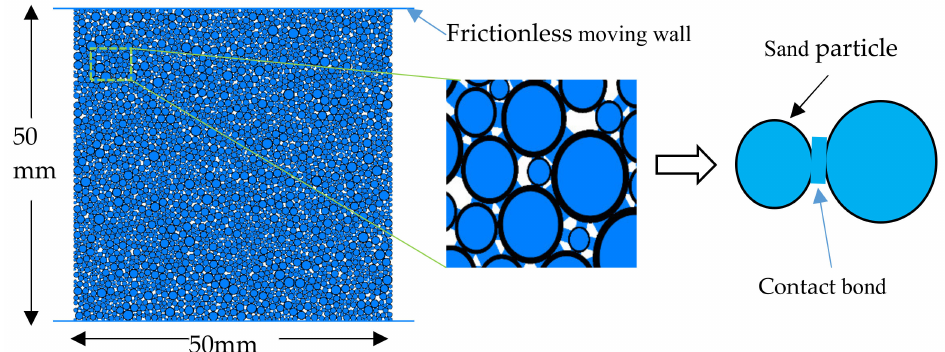
Figure 4. Characteristics of the numerical specimen (all sand particles contacts were linear parallel bond contact which was plot as blue line).